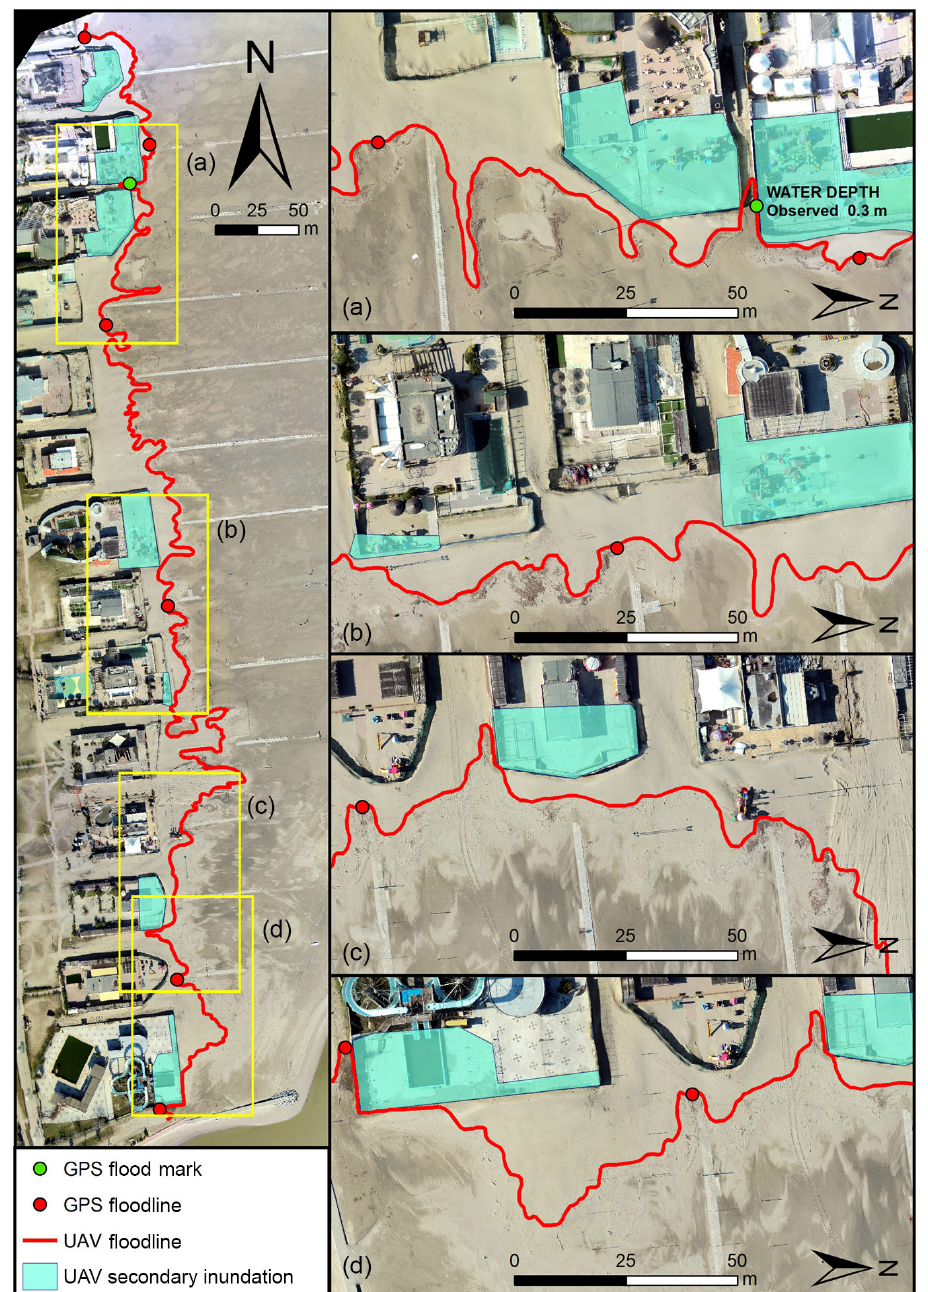
Figure 8. Observed GPS floodline and GPS flood mark (green and red circles), UAV (solid red line and light-blue polygons) flood extension comparisons: the box on the left shows an overview of the target area while on the right (a, b, c, d) some spot focuses are